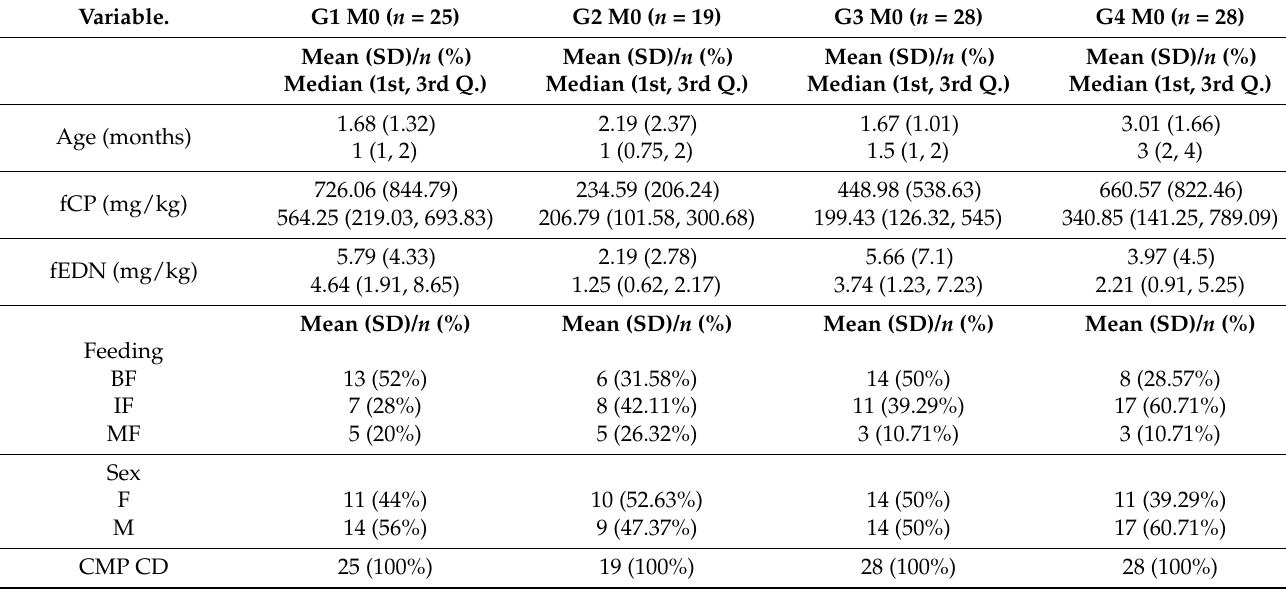
Table 3. Description of G1, G2, G3 and G4; and mean, standard deviation, median and first and third quartile levels of fCP and fEDN from infants with CMP consumption in their diet (sample M0) from the 4 groups. Variable.